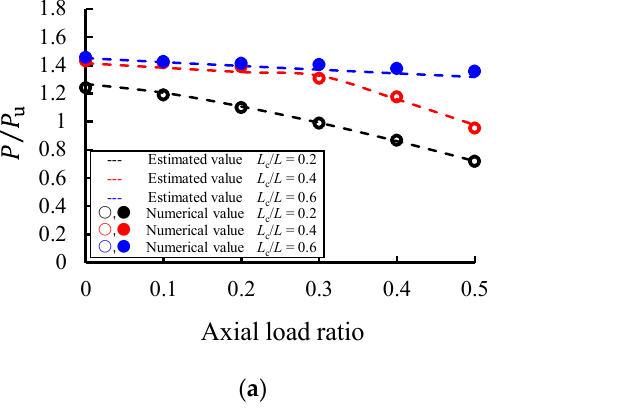
Figure 14. Maximum load bearing capacity and modified estimation equations for models C-009-020 and C-009-040: ( a ) Model C-009-020; ( b ) Model C-009-040.